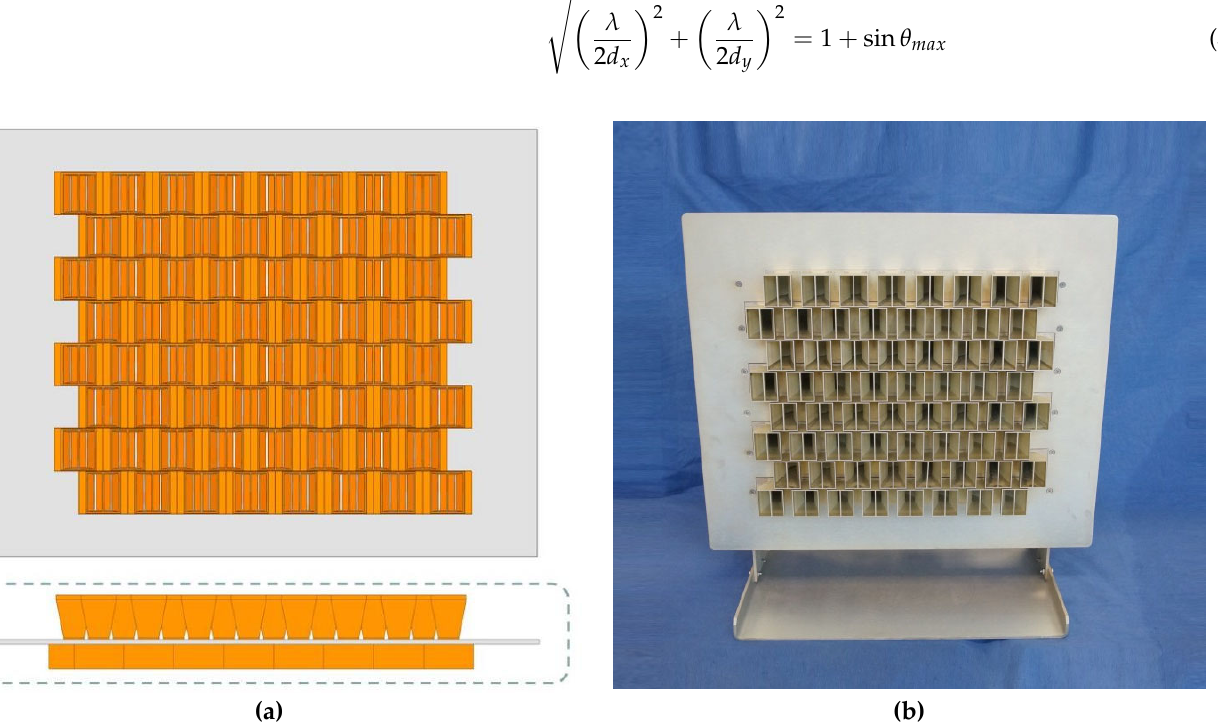
Figure 9. The geometry of the 8 × 8 phased array antenna: ( a ) simulated model and ( b ) manufactured model.